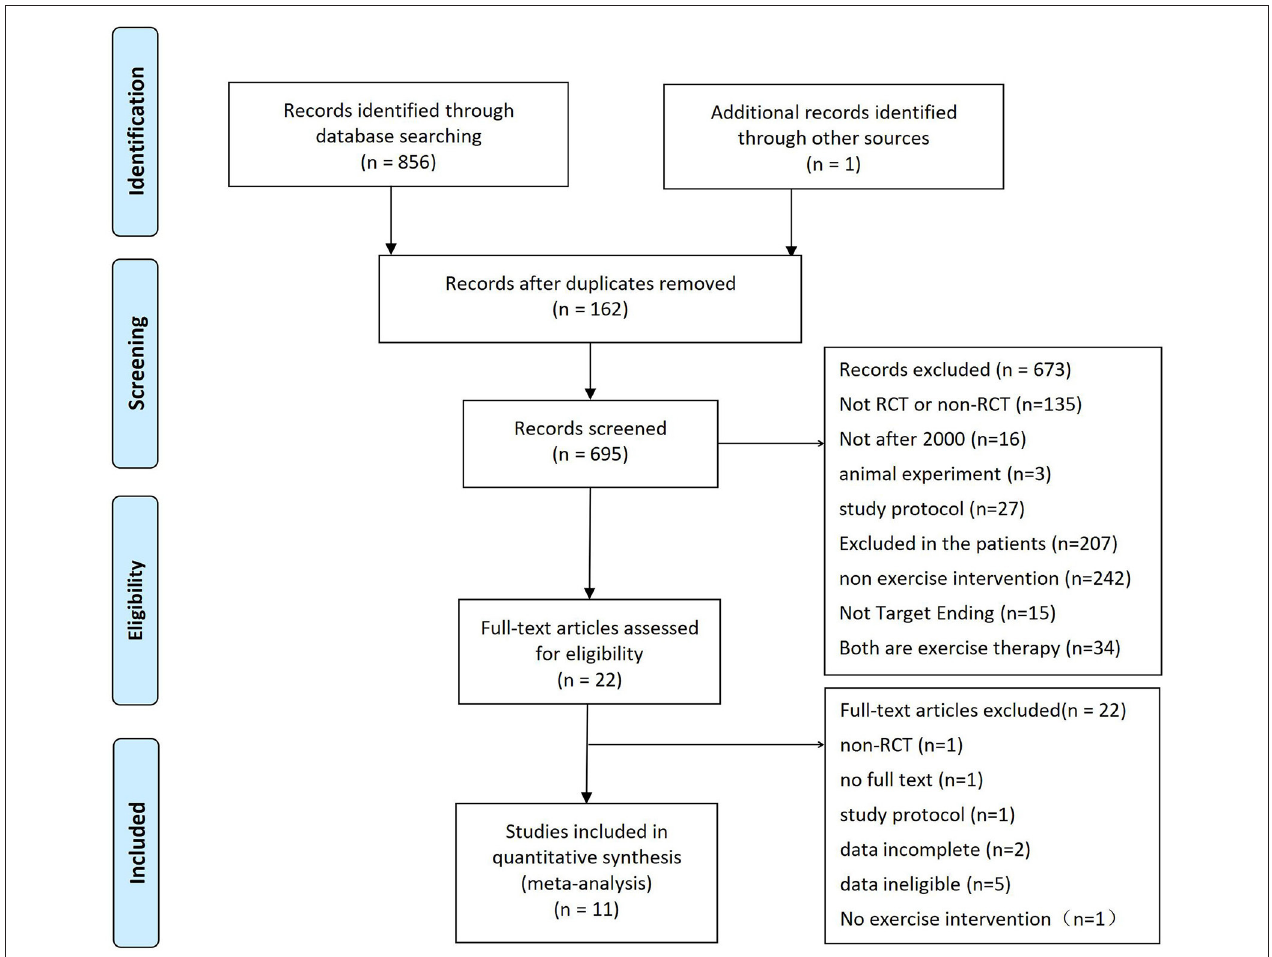
FIGURE 1 | Flow of the trial selection